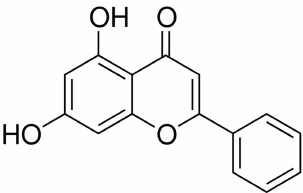
Figure 1. The chemical structure of chrysin.